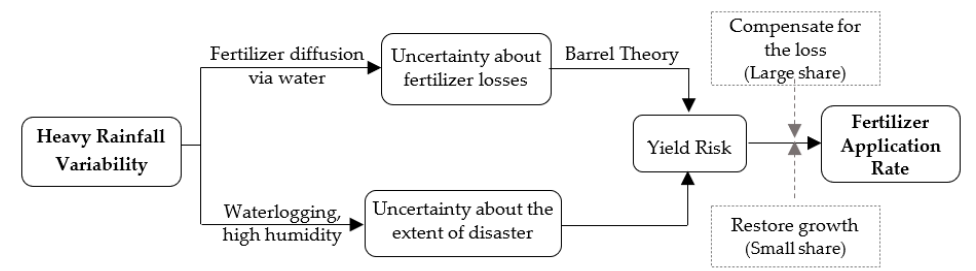
Figure 2. Heavy rainfall variability and farmers’ fertilizer use.